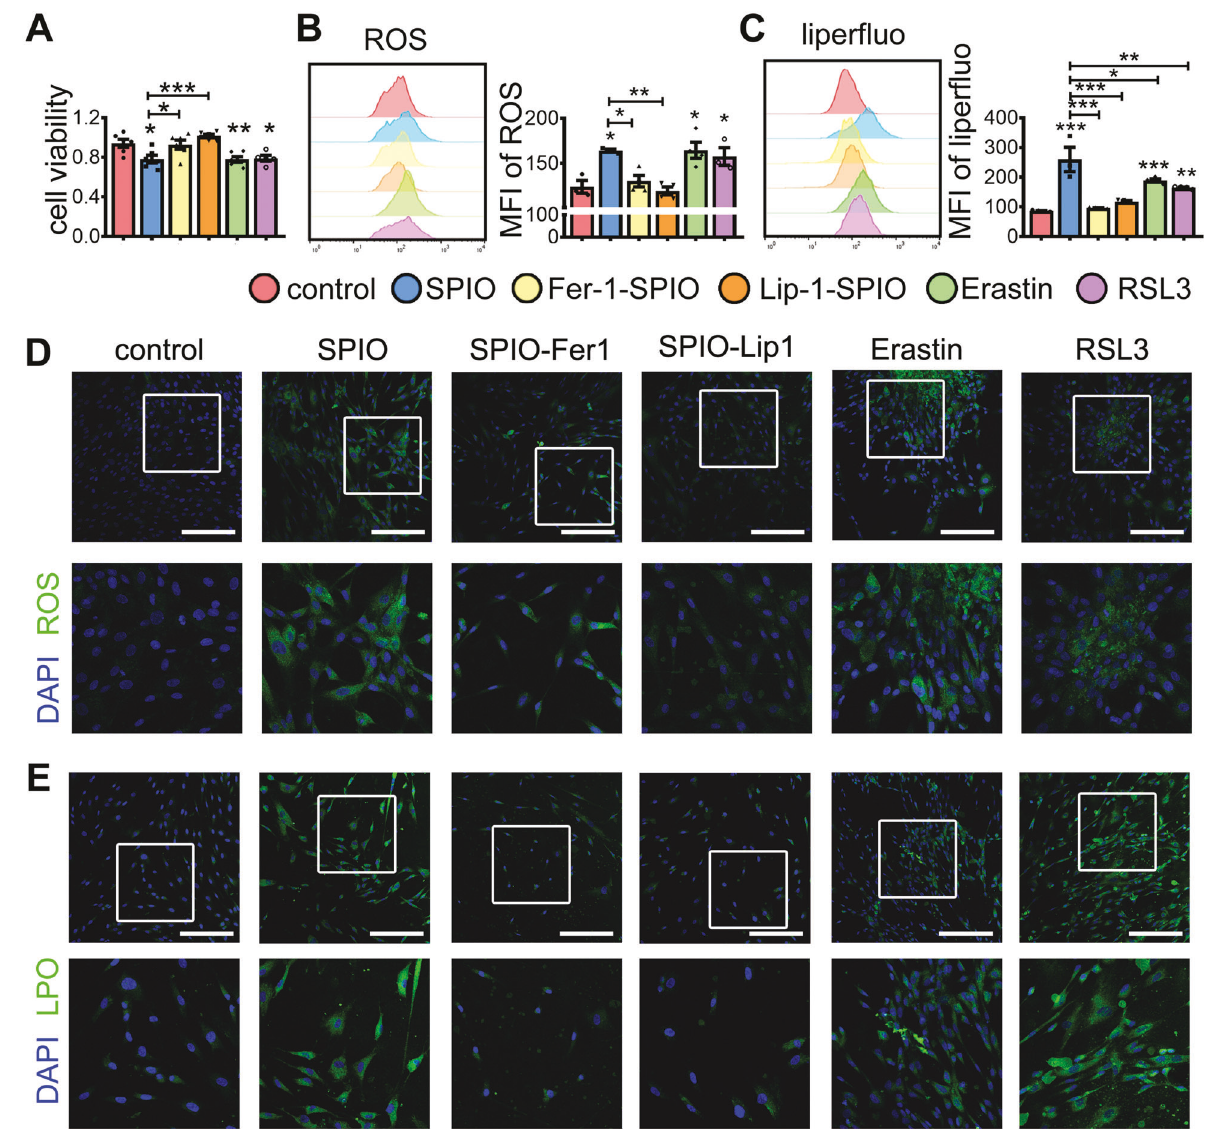
Fig. 4 Fer-1 and Lip-1 reduced the ferroptosis of MSC SPIO . MSCs were treated with Erastin (100 nmol/L) or RSL3 (10 nmol/L) or treated with Fer-1 (10 μ mol/L) or Lip-1 (20 μ mol/L) during SPIO labeling. Cells were harvested at 24 h. A Cell viability of MSCs under different treatment was measured by CCK-8 assay. B , D The intracellular ROS level was measured by B fl ow cytometry and D confocal microscope. C , E The intracellular level of lipid peroxide was measured by C fl ow cytometry and E confocal microscope. Scale bars, 200 μ m. Data are shown as mean ± SEM ( n = 3). * p < 0.05; ** p < 0.01; *** p <